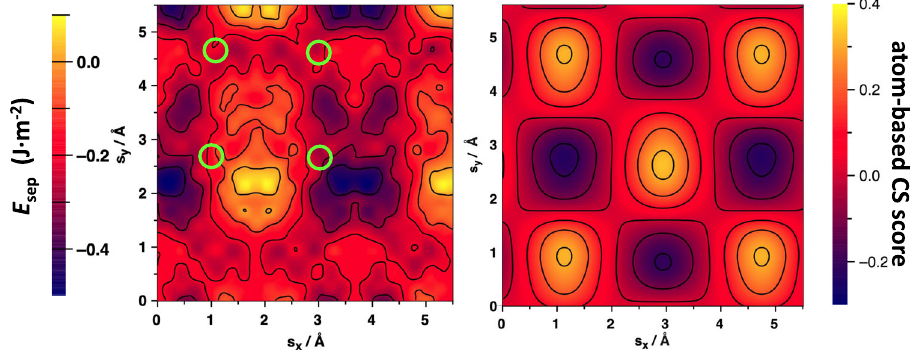
Fig. 5 | Comparing E sep values with atom-based CS score values. Comparison between displacement maps for the anatase (101)/(001) interface at α =0° derived from:(1)explicitlytheevaluatingtheinterfacestructureandrelativeenergywithan IP (left)inourdiskinterfaceapproach,and (2)byapplyingasigned atom-based CS